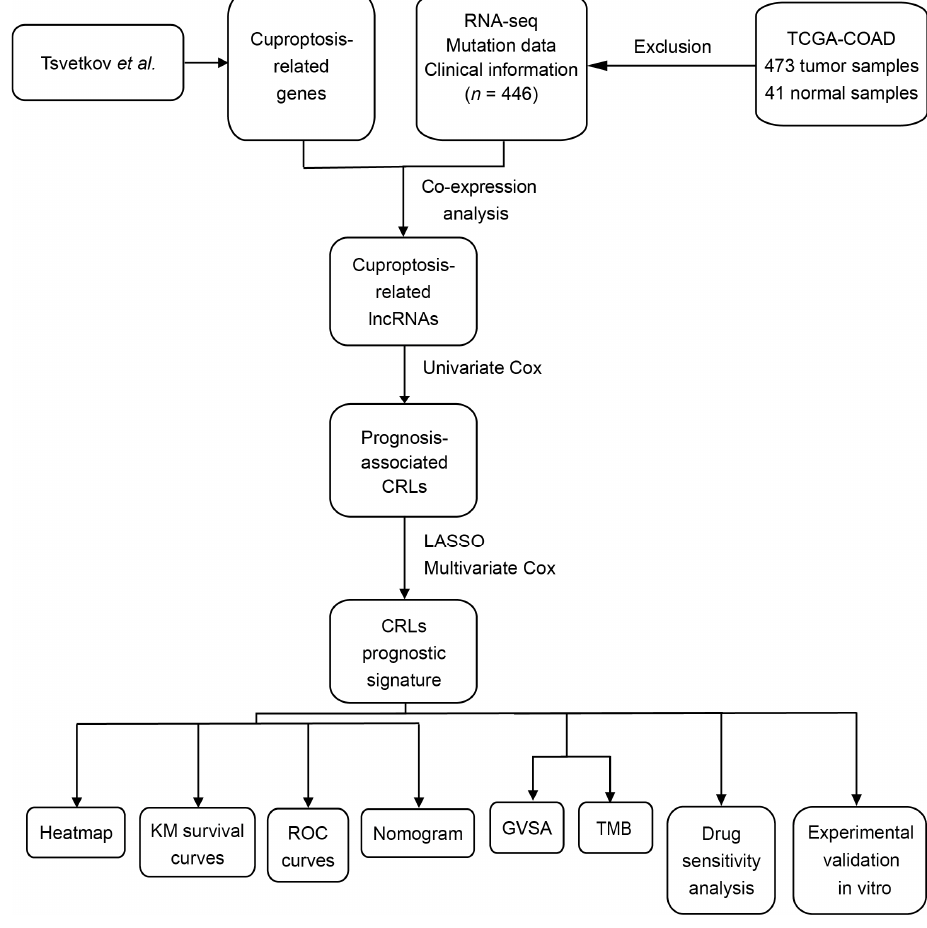
Figure 1. Flow chart of this